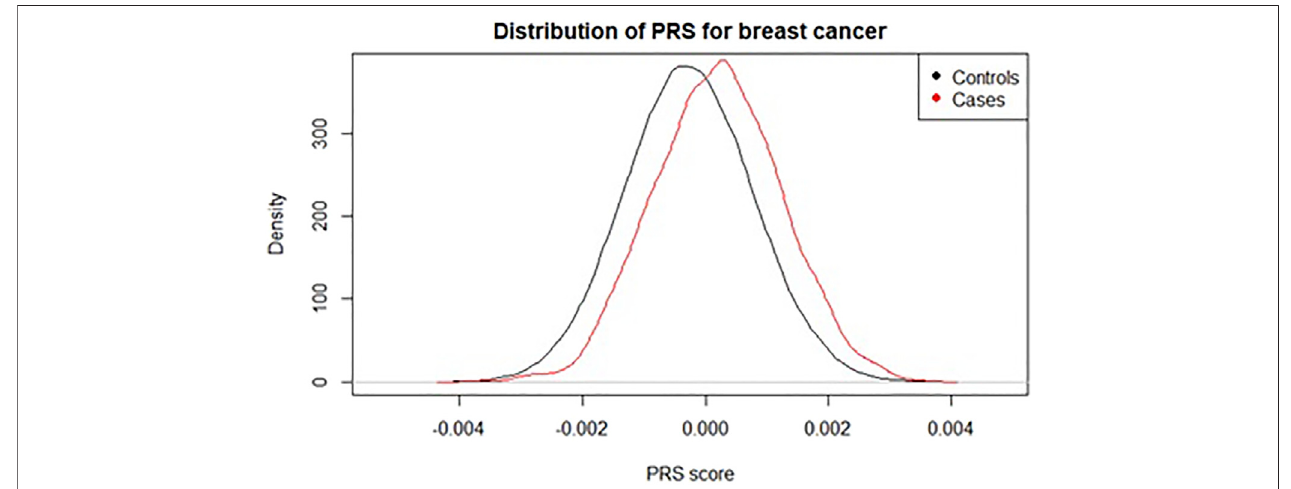
FIGURE 1 | Distribution of a polygenic risk score for breast cancer among individuals with and without registry-veri fi ed breast cancer events in UK Biobank (4,789 cases). Score used was 313-SNP PRS from (Mavaddat et al., 2019).